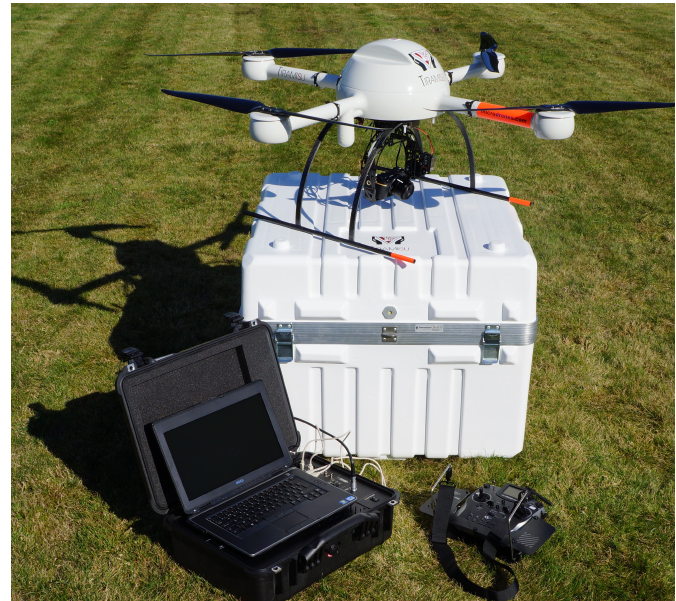
Figure 14. UAV used for the data